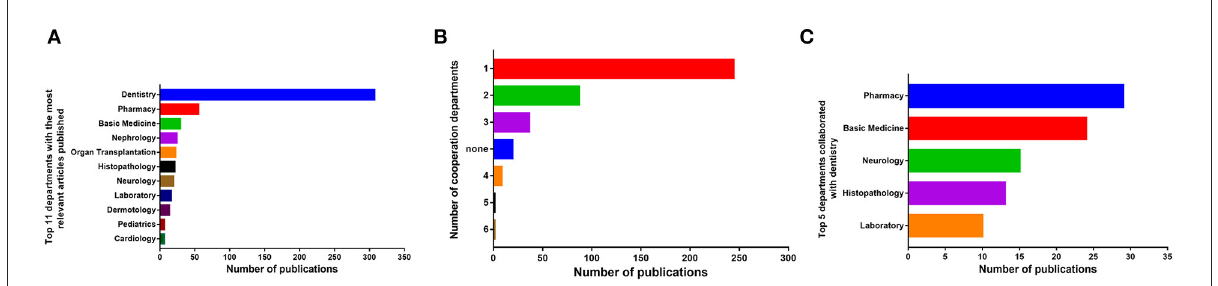
FIGURE4 Collaborative studies of DIGO. (A) Top-11 departments that have published the most relevant articles. (B) Number of cooperation departments per article. (C) Top-5 departments collaborated with dentistry. none: No source of department